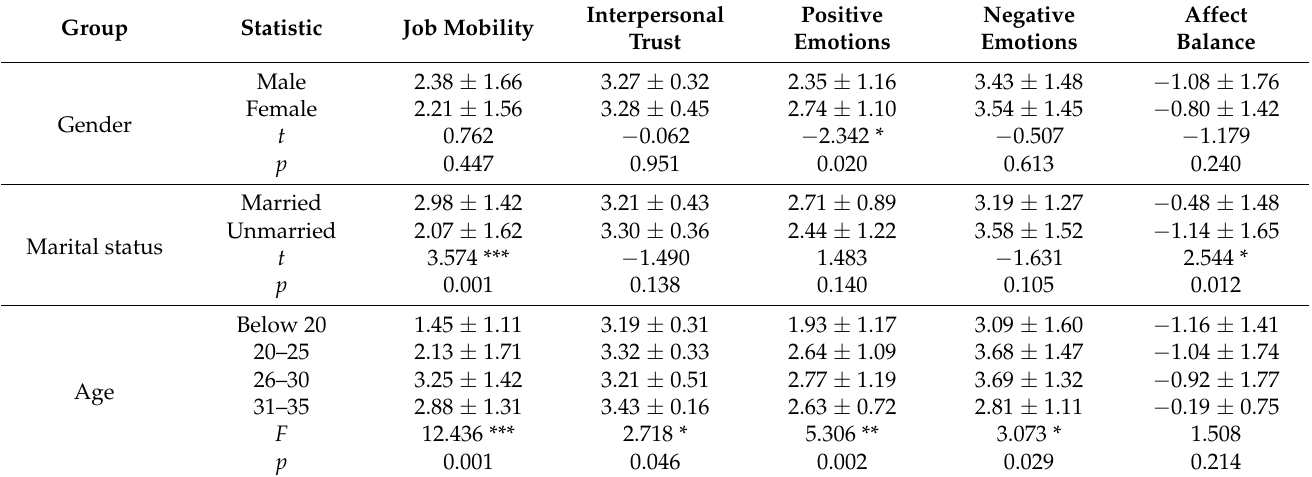
Table 2. Difference analysis of the scale scores of the present study ( n = 192).